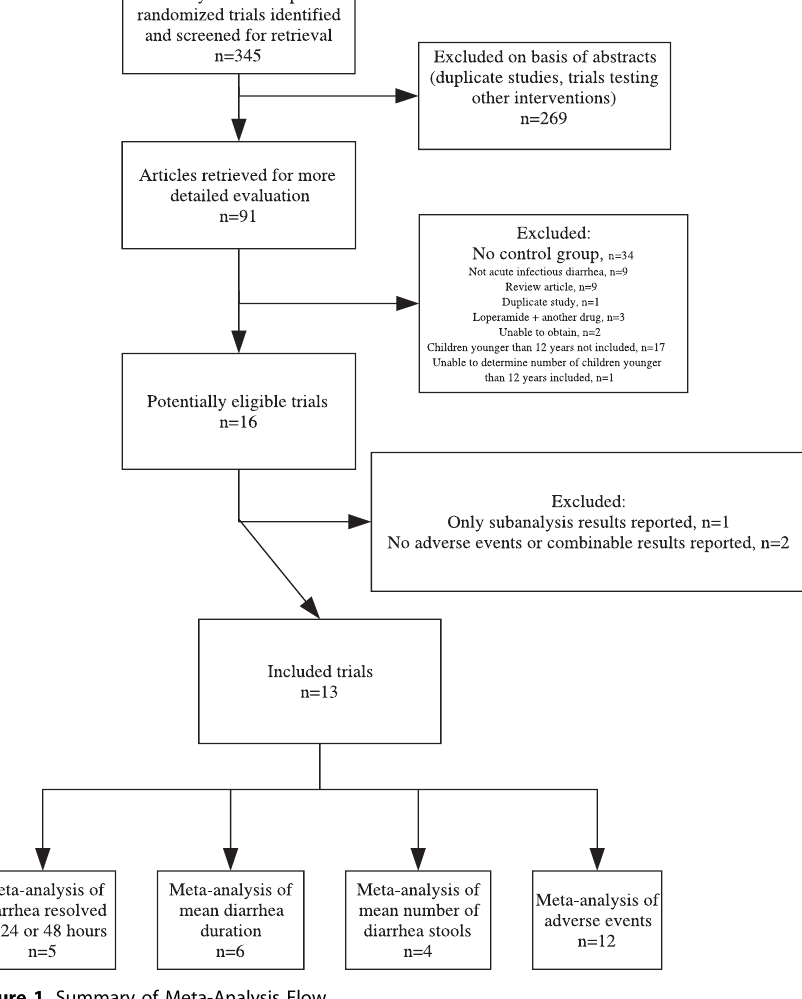
Figure 1. Summary of Meta-Analysis